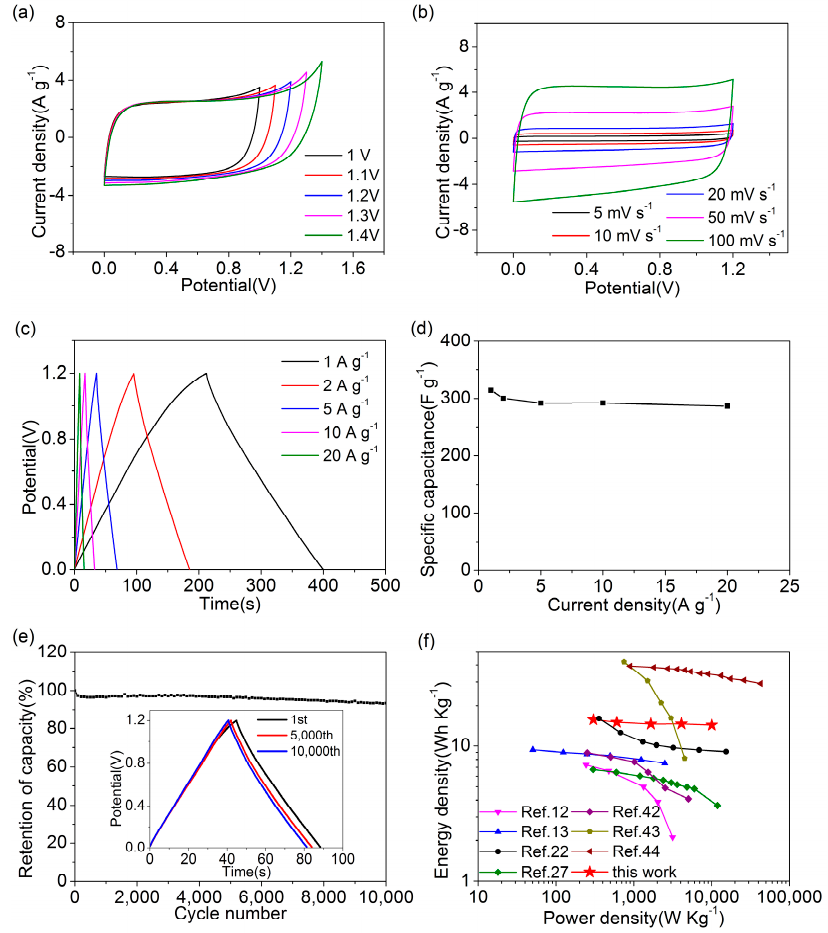
Figure 7. The electrochemical characteristics of symmetric supercapacitor of PRK3N1: ( a ) CV curves at 50 mV·s − 1 with different potential windows; ( b ) the CV curves at various scan rates from 5 to 100 mV·s − 1 ; ( c ) the GCD curves from 1 to 20 A·g − 1 ; ( d ) the specific capacitances of symmetric supercapacitor from 1 to 20 A·g − 1 ; ( e ) cycle stability at 4 A·g − 1 , the GCD curves of the 1st cycle, 5000th cycle and 10,000th cycle are shown in the inset; ( f ) the Ragone plots of PRK3N1 and other reported symmetric supercapacitors.